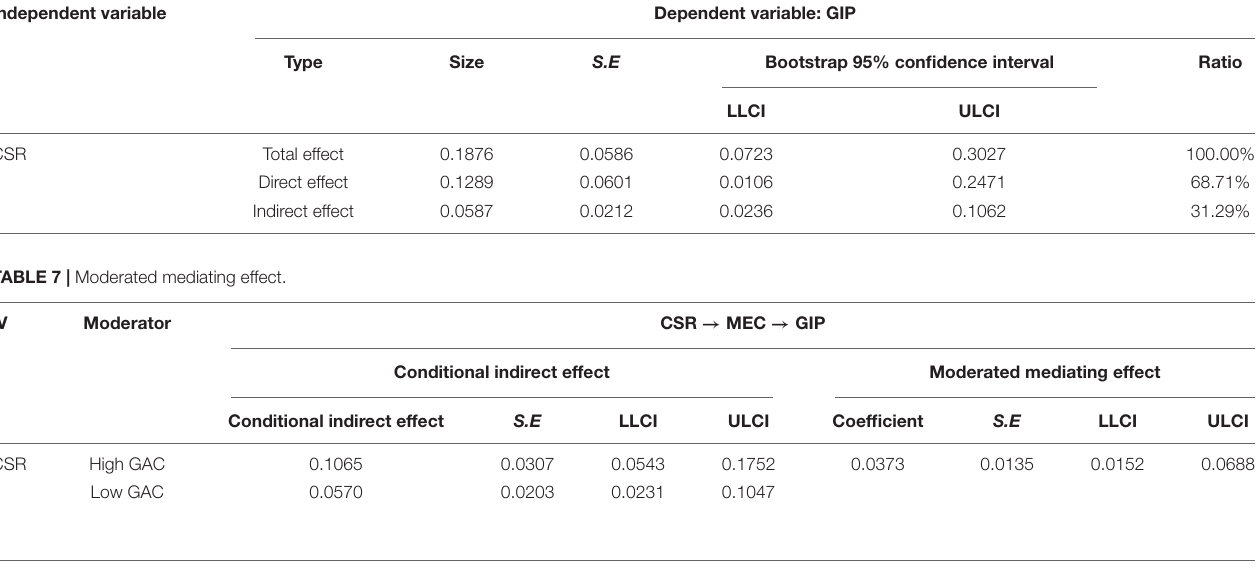
TABLE 6 | Bootstrap for the mediating effect. Independent variable